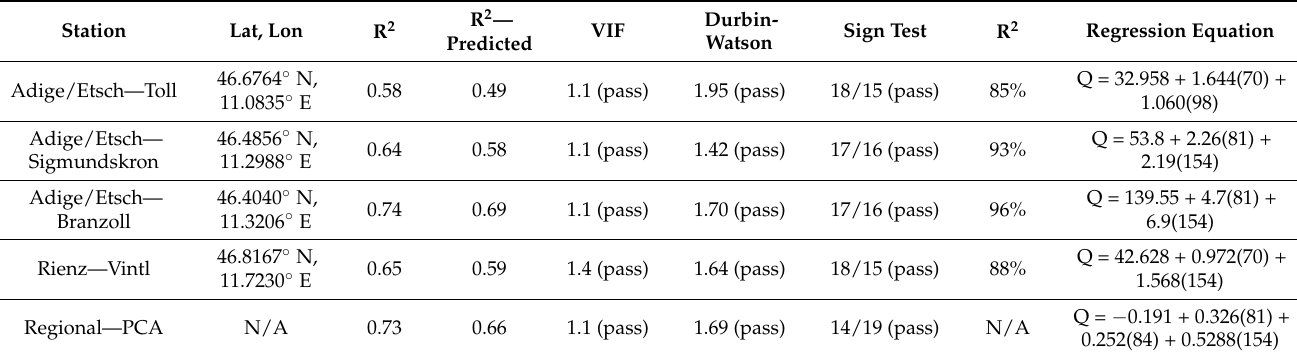
Table 1. Streamflow stations, Latitude, Longitude, R 2 , R 2 —predicted, Variation Inflation Factor (VIF), Durbin-Watson, R 2 (individual gauge versus PCA generated regional annual streamflow vector) and Regression Equation for Regression Model (scPDSI cell number in